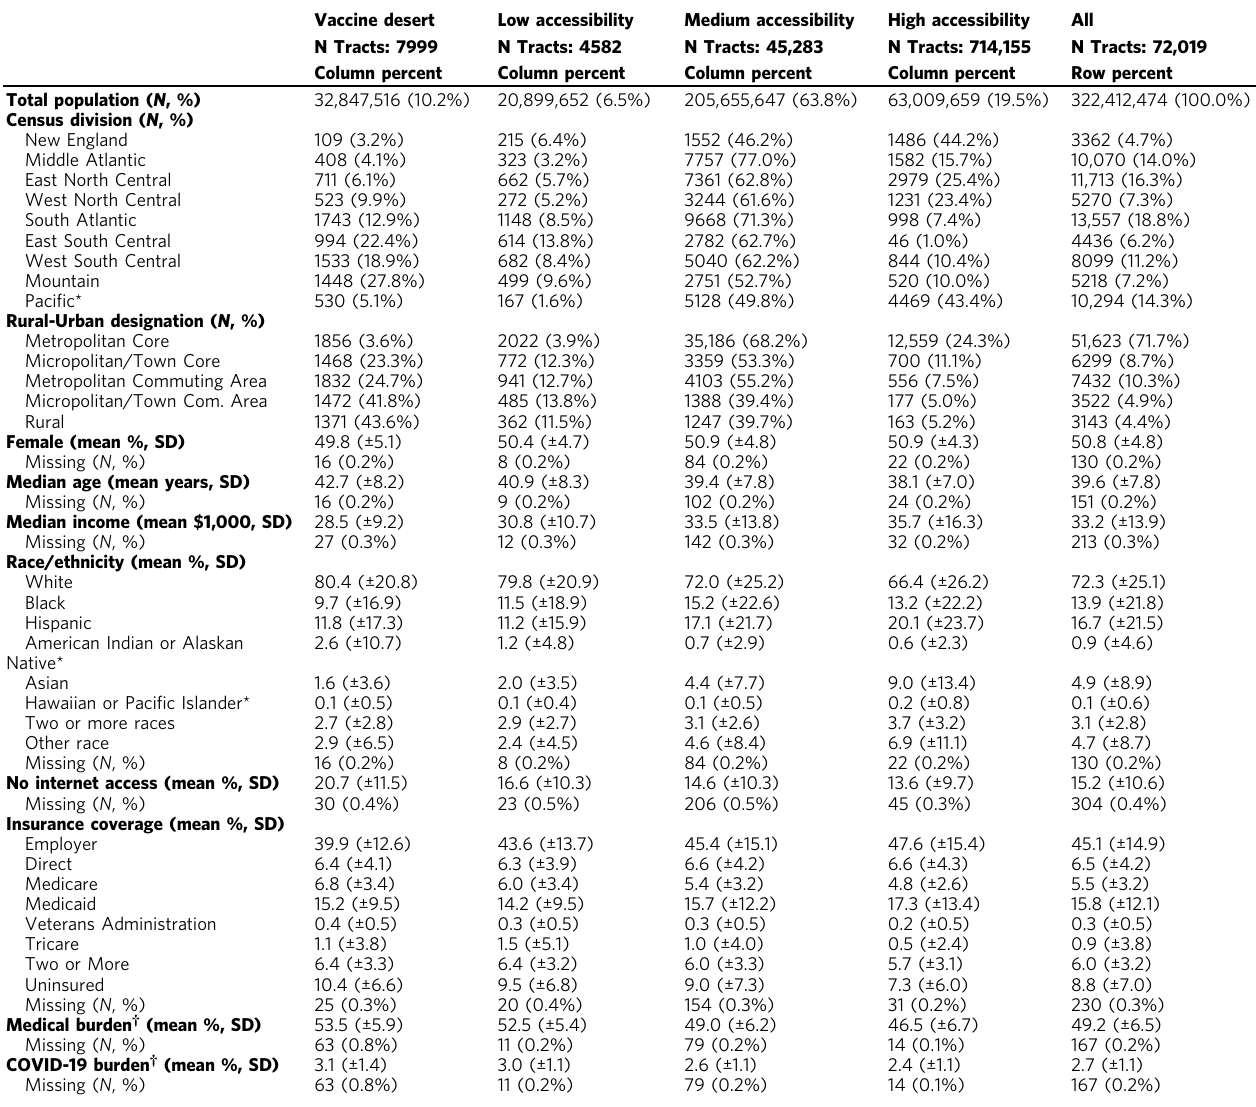
Table 1 Census tract demographics by accessibility score for the Contiguous United States Vaccine desert Low